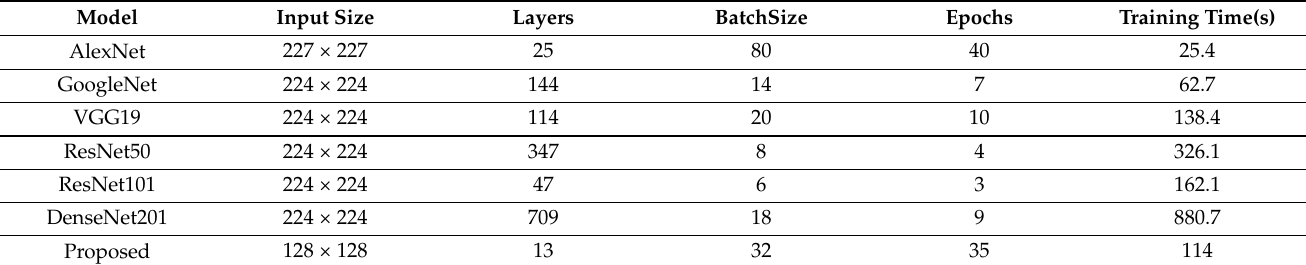
Table 3. Model-wise comparison with different parameters.